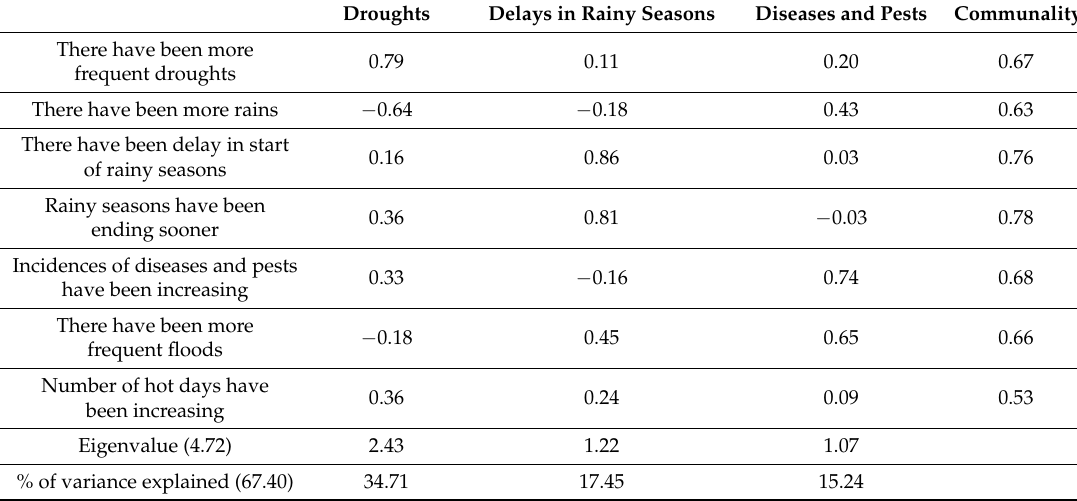
Table 2. Factor loadings and communalities for climate change perceptions of farmers in the Central region ( n = 253). Droughts Delays in Rainy Seasons Diseases and Pests